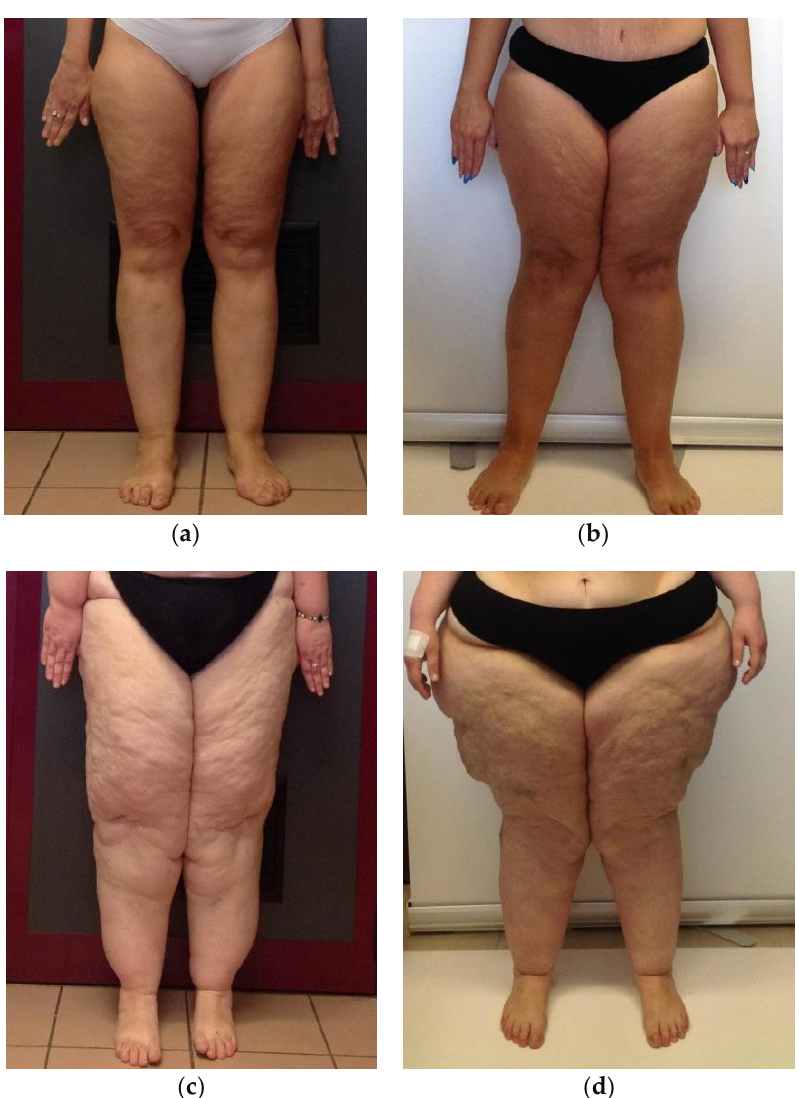
Figure 1. Pictures of different stages of lipoedema. ( a ) Stage 1: the skin is still smooth and appears normal but with pain, bruising and nodules in the fat tissue. ( b ) Stage 2: the skin is characterized by a mattress-like pattern with the presence of fibrosis, development of nodular or mass-like appearance of the subcutaneous fat, lipomas and/or angiolipomas. ( c ); Stage 3 involves the loss in elasticity, inhibition of mobility, inflammation followed by constant and palpable fibrosis. ( d ) Stage 4: presence of both lipoedema and lymphoedema.